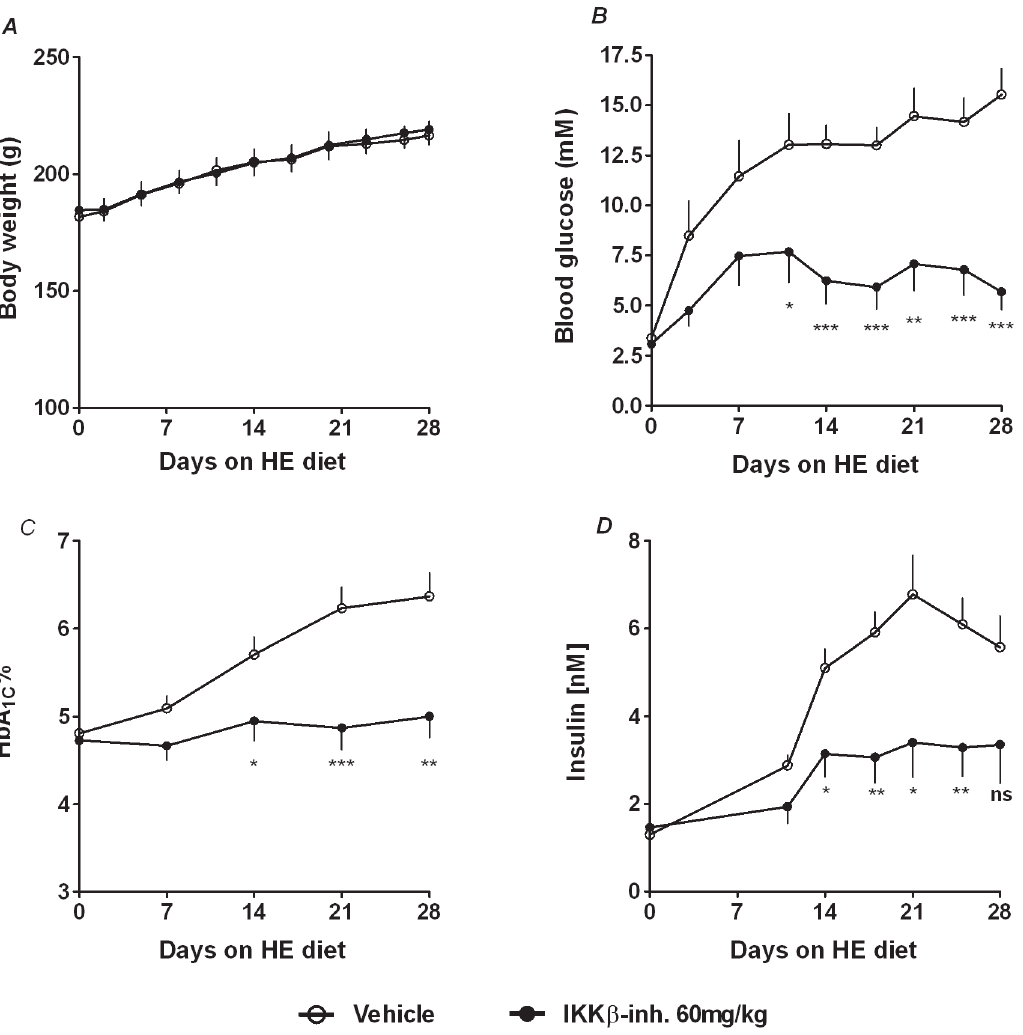
Figure 5. IKK b inhibition prevents diet induced diabetes in P.obesus . Diabetes-prone male and female P. obesus , age of 13–14 weeks, were transferred from ad libitum low energy diet to ad libitum high energy diet. At the same day (day 0) treatment was initiated with vehicle (open circles n=12) or with the IKK b -inhibitor (black circles n=10). A : Body weight was measured daily. B : Non fasting blood glucose was measured twice weekly. C : HbA1c was measured once weekly. D : Insulin was measured at day 0, 11 and then twice a week through the rest of the study. All data are shown as the mean 6 S.E.M. (*p , 0,05; **p , 0,01; ***p , 0,001).